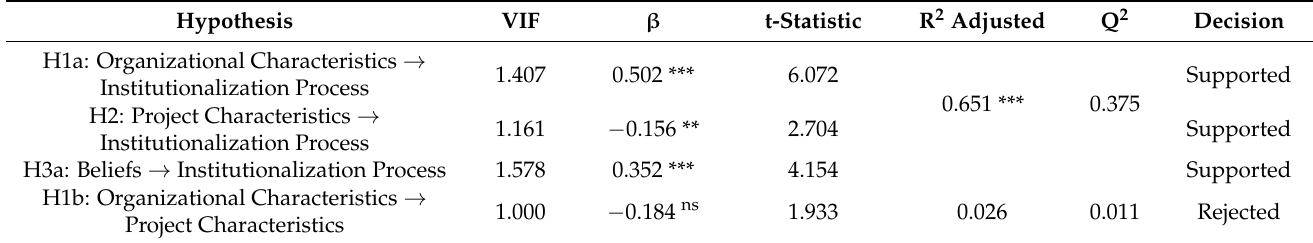
Table 3. Summary of the structural model.